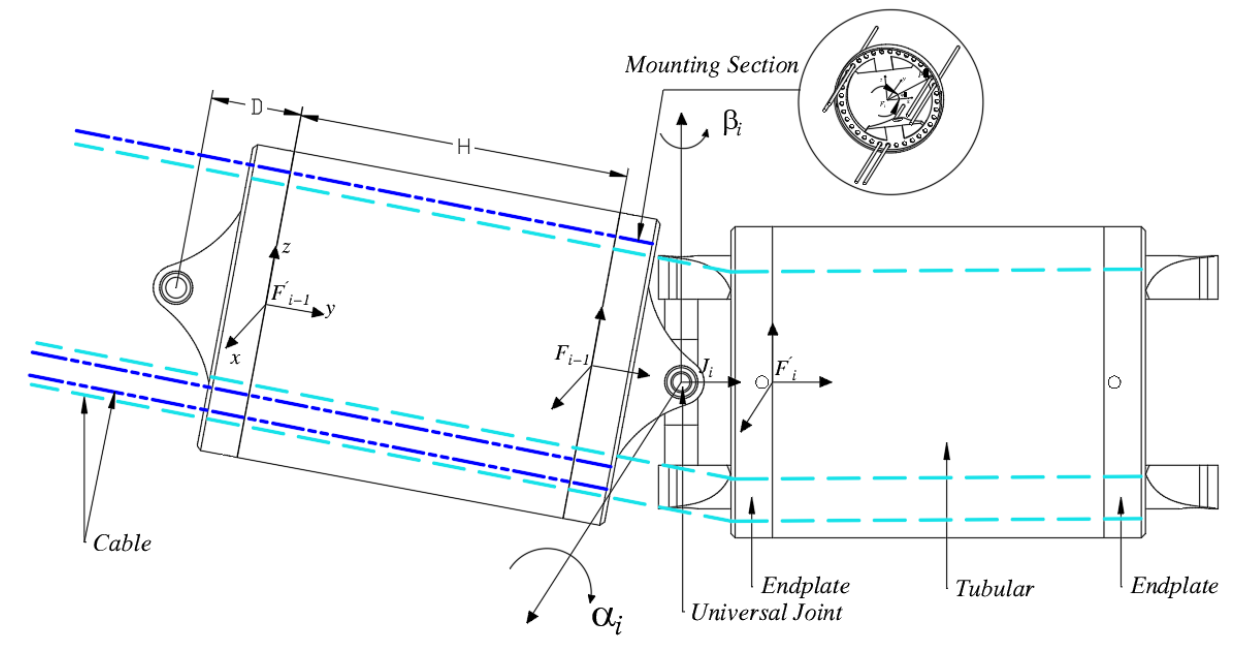
Figure 4. A geometric model between two tubular